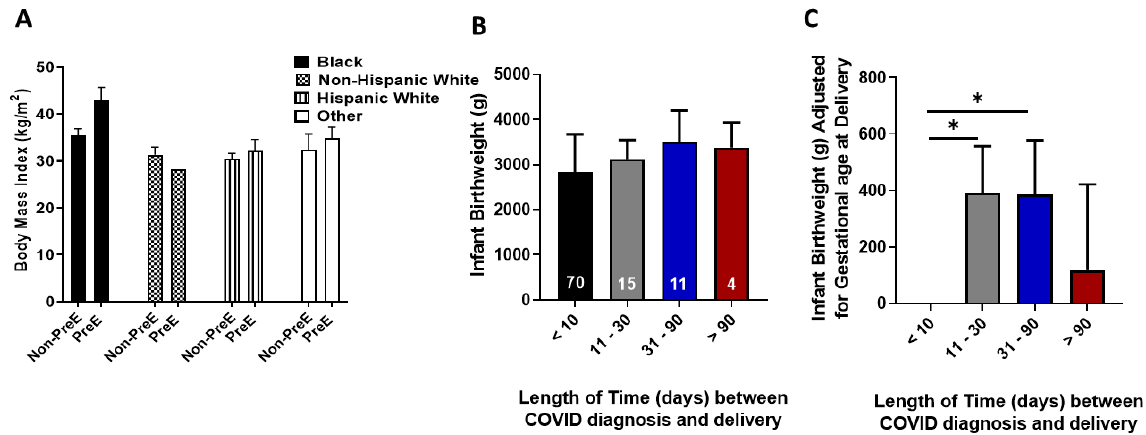
Figure 1. ( A ). Body mass index was compared between women with and without preeclampsia (PreE) within racial and ethnic groups. ( B ). Infant birthweight was compared for the length of time between gestational age at COVID-19 diagnosis and gestational age at delivery. The number in white denotes the number of women in each category. ( C ). When differences in infant birthweight was adjusted for gestational age at delivery and then compared to the time interval between gestational age at COVID-19 diagnosis and gestational age at delivery, infants who were born less than 10 following a positive COVID-19 diagnosis had statistically lower weights relative to infants born 11–90 days following a positive maternal COVID-19 diagnosis. * denotes p < 0.05 between the indicated groups.